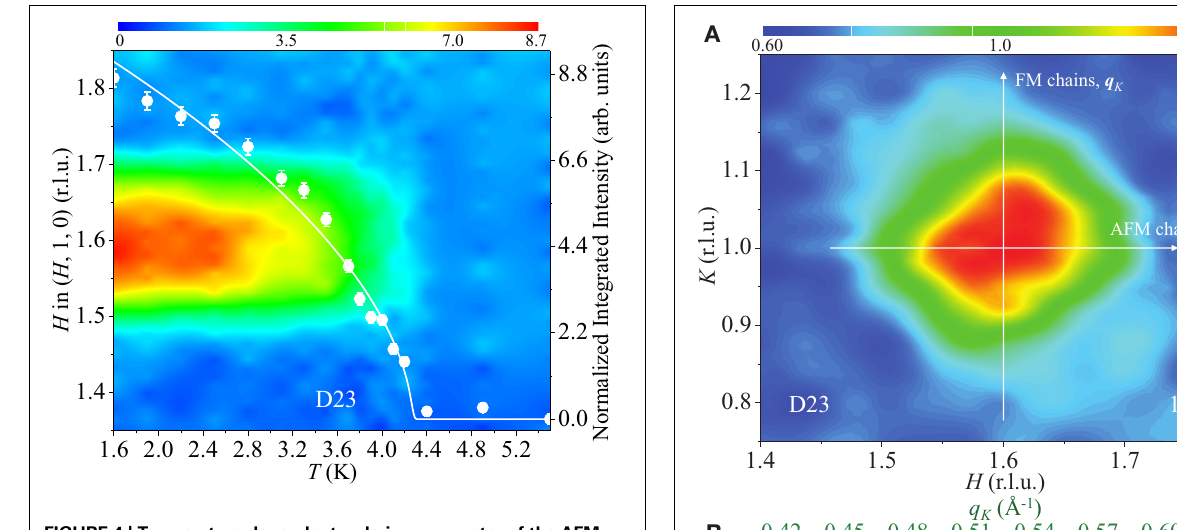
FIGURE 4 | Temperature-dependent ordering parameter of the AFM transition. Temperature dependent H -scans around the AFM (1.6, 1, 0) Bragg peak (left ordinate) performed at D23 (ILL) and the corresponding integrated intensities (circles) (right ordinate). The solid line is the fit with a power law as described in the text. The error bars are statistical errors.